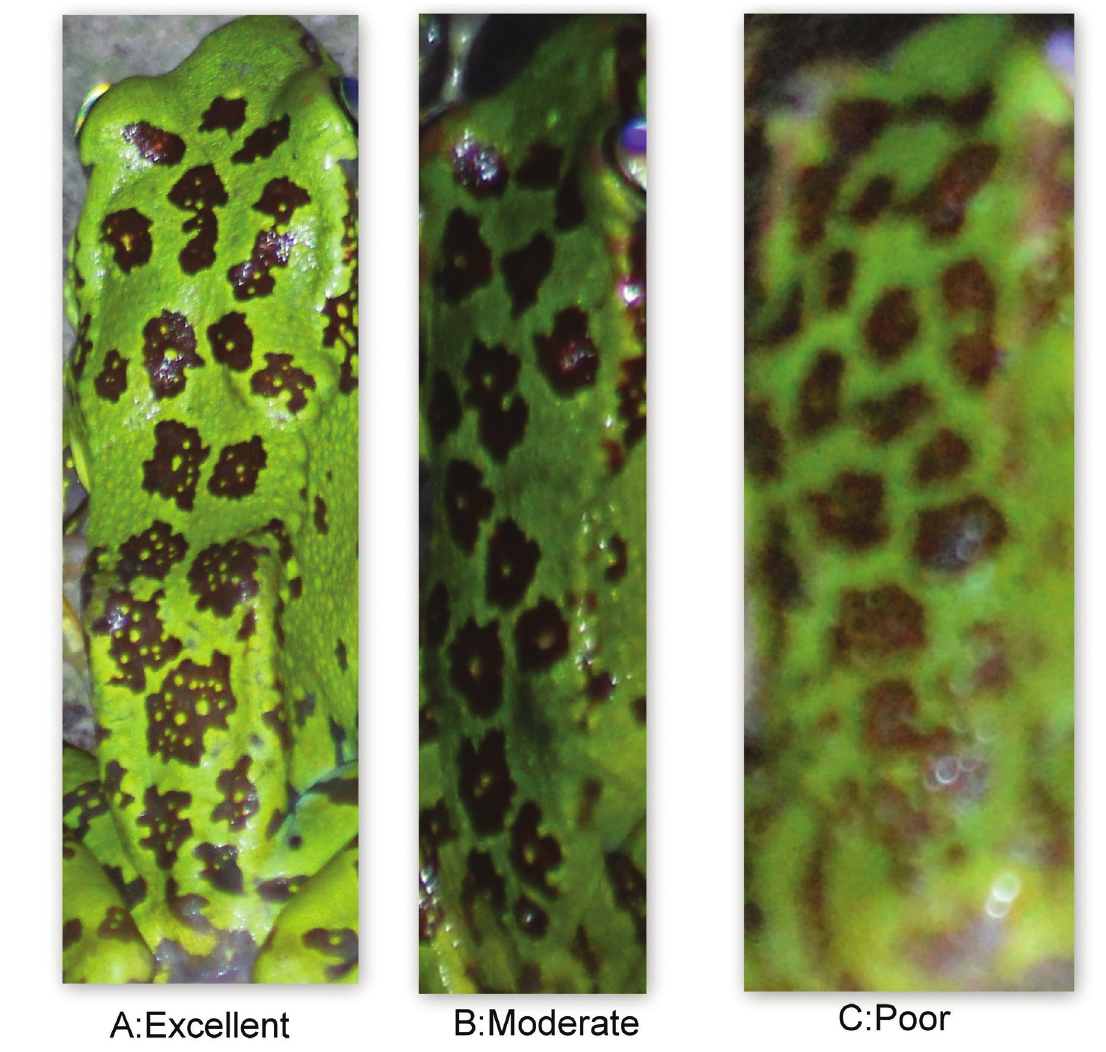
Figure 4. Photographs were categorized into three categories based on their